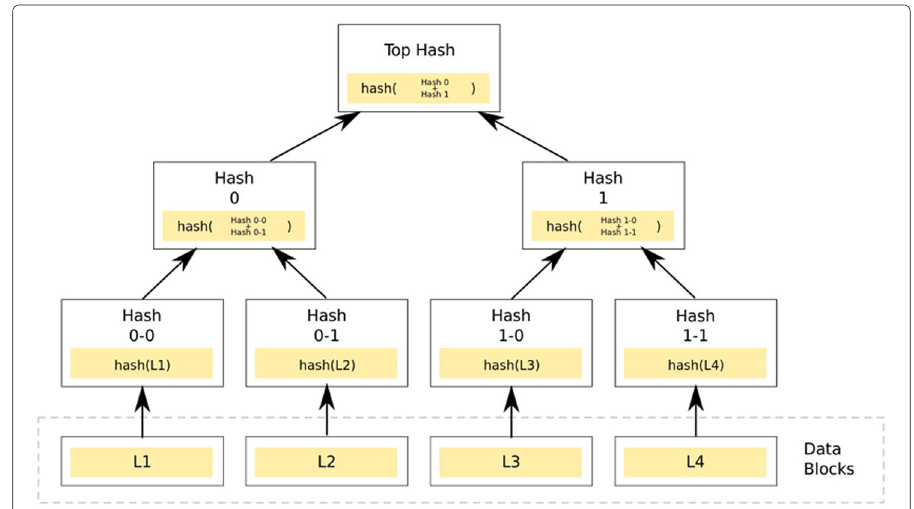
Fig. 1 An example of a Merkle Tree. The working mechanism of Merkle